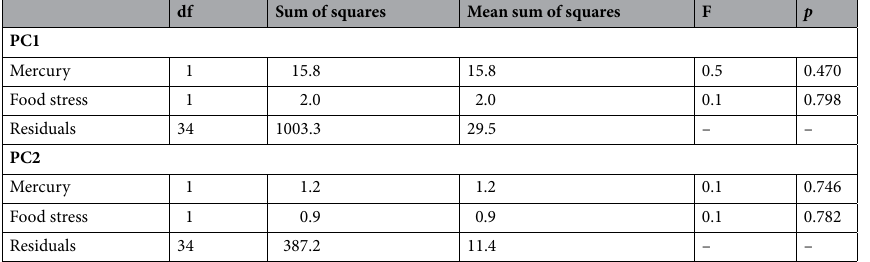
Table 1. Results of ANOVA tests using factor scores from the first two principal components of PCA to test for differences in uropygial gland microbiota among treatment groups (dietary methylmercury, Y/N; unpredictable food stress, Y/N) in captive song sparrows (see Table S3 for factor